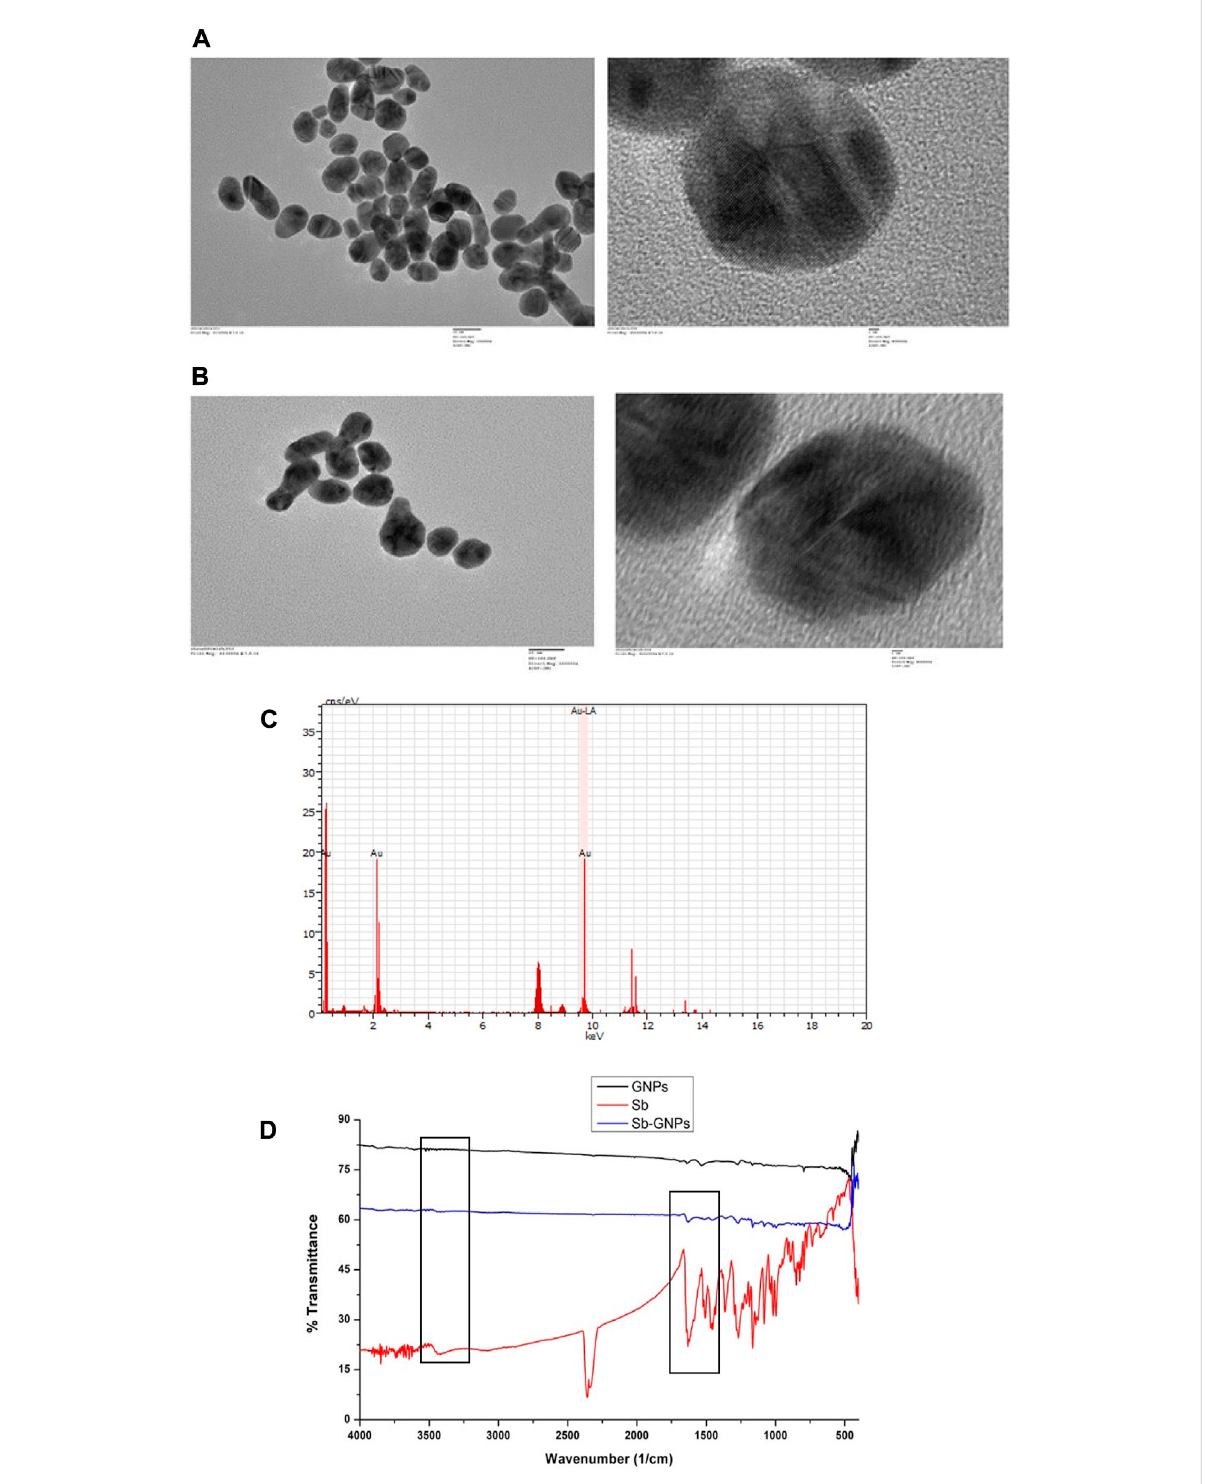
FIGURE 5 (A) Transmission electron microscopy (TEM) images of free, puri fi ed gold nanoparticles; (B) Transmission electronmicroscopy (TEM) imagesof Silibininconjugatedgoldnanoparticles; (C) EnergydispersiveX-rayanalysis(EDAX)ofgoldnanoparticlesandSilibininconjugatedgoldnanoparticles; (D) Fourier transformed infrared spectroscopy (FTIR) spectra of free, puri fi ed gold nanoparticles, free Silibinin and Silibinin conjugated gold